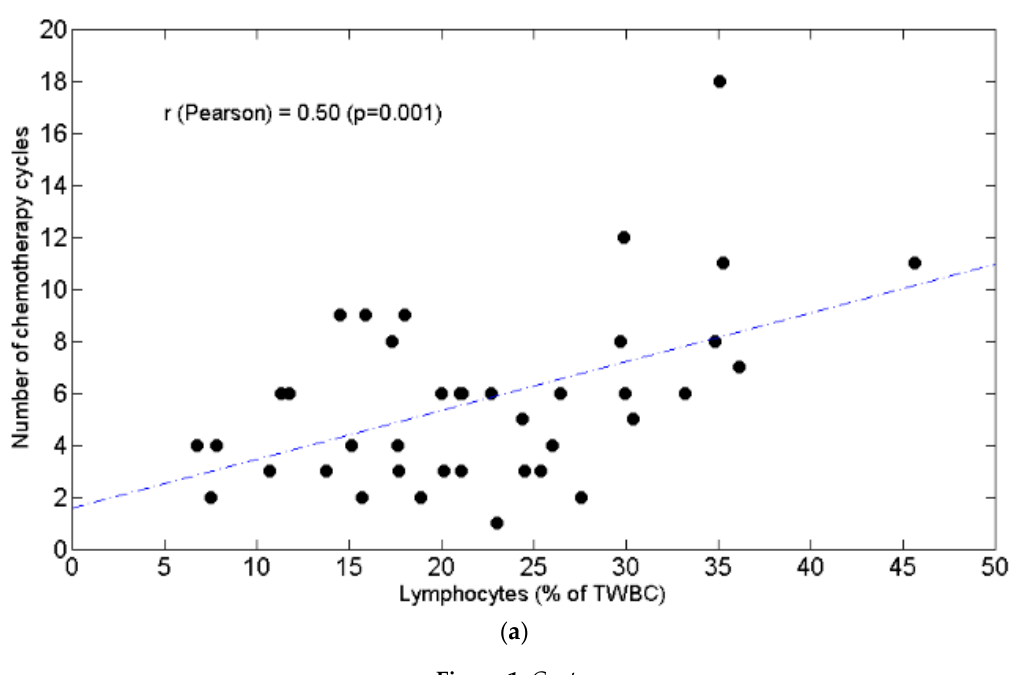
Figure 1. The number of chemotherapy cycles is positively associated with circulating lymphocytes expressed as percentage of Total White Blood Cells (Figure 1a). The number of chemotherapy cycles is not significantly linked to circulating absolute lymphocytes (Figure 1b).